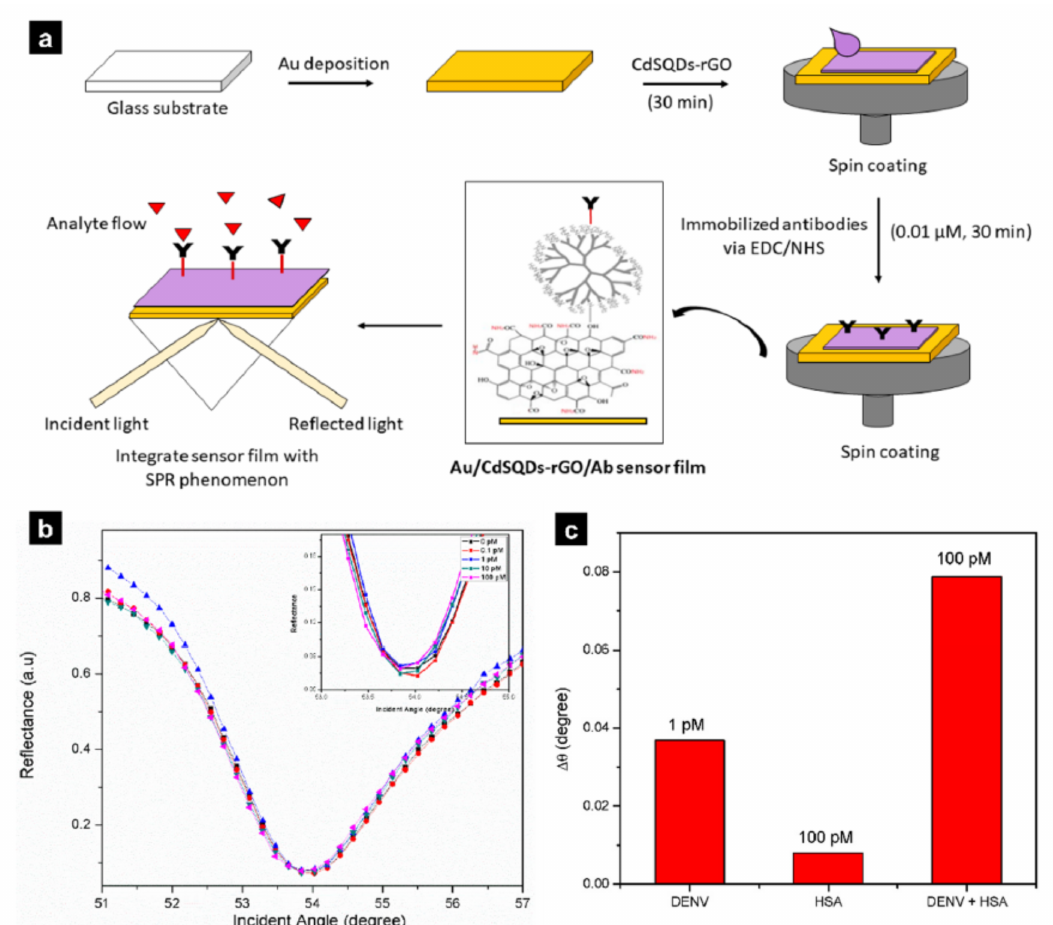
Figure 4. ( a ) Schematic illustration of the biosensor fabrication process. ( b ) Plot indicating the limit of detection and linear range. ( c ) Selectivity of the fabricated platform. With permission from [83], Copyright 2019,